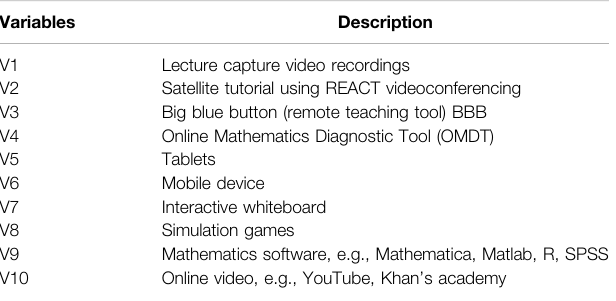
TABLE 1 | Description of the data